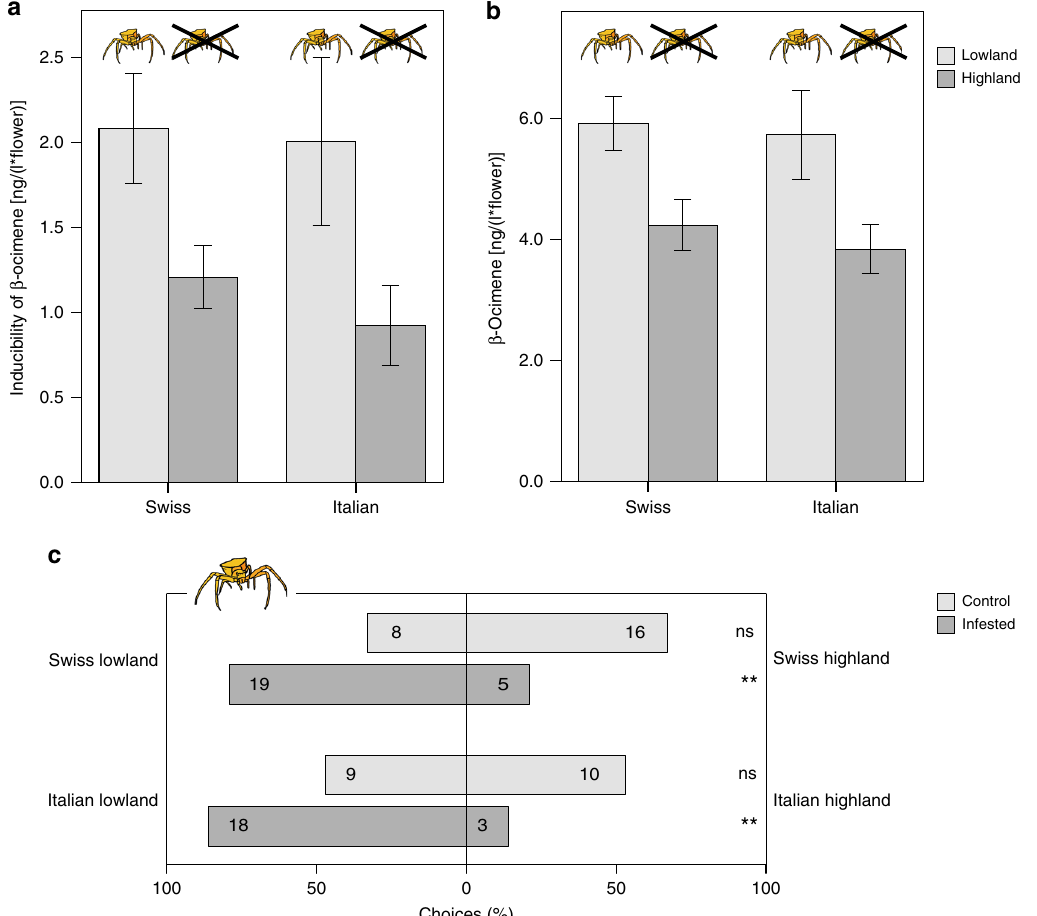
Fig. 5 Adaptation of Biscutella laevigata populations to crab spiders. a Inducibility of β -ocimene emission in lowland (with spiders) and highland (without spiders) populations, in the Swiss and Italian lineage ( N = 110). Inducibility was signi fi cantly higher in lowland populations than in highland populations (linear model: estimate ± 0.09 ± 0.04, t = 2.034, P = 0.044). The lineage (Swiss vs. Italian) on the other hand did not affect the inducibility of this compound ( t = 0.565, P = 0.57). b Absolute emission of β -ocimene after fl orivore infestation in low- and highland populations, in the Swiss and Italian lineage ( N = 110). Lowland populations emitted signi fi cantly higher amounts of β -ocimene compared to highland populations (estimate ± s.e. = 1.7 ± 0.7, t = 2.444, P = 0.016). The lineage (Swiss vs. Italian) on the other hand had no effect on the amount of β -ocimene ( t = 0.545, P = 0.59). c Dual-choice behavioral assays testing the preference of crab spiders for lowland B. laevigata plants against highland plants, for the Swiss and Italian lineage separately. Numbers in bars are the absolute number of crab spiders selecting each side. Binomial test: ns: P > 0.05, * P < 0.05, ** P < 0.01, *** P <